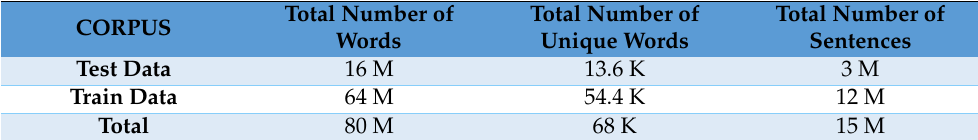
Table 2. Specifications of the Uzbek language corpus